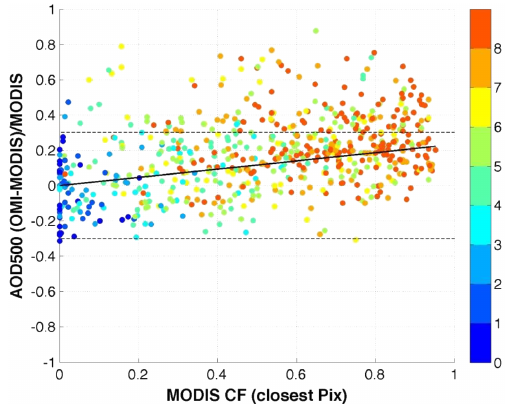
Figure 5. Relative difference of OMI and MODIS (at 500nm) AODs as a function of the cloud fraction in the MODIS retrieval (MODIS aerosol algorithm). The cloud contamination outside the selected MODIS pixel but still within the OMI pixel is represented by the color bar. It displays the number of immediate MODIS pix- els around the selected one with CF>0.3 (out of eight surround- ing). This figure demonstrates that OMI retrieves a larger AOD than MODIS as cloud fraction